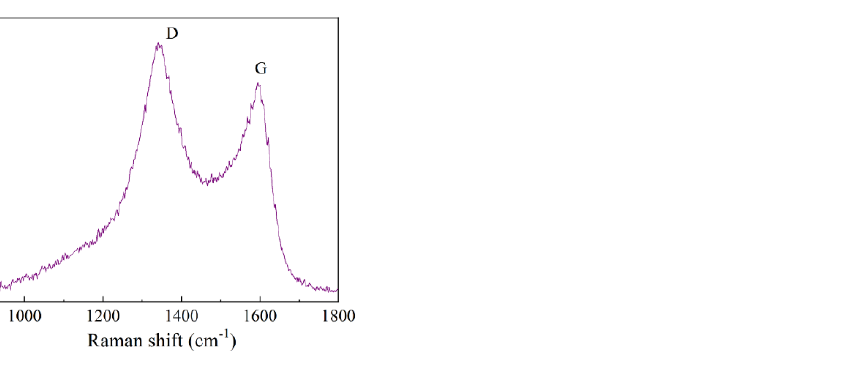
Figure 4. The Raman spectrum for the interval from 950 to 1800 cm −1 for Fe@C nanocomposite, measured under excitation at 514 nm.